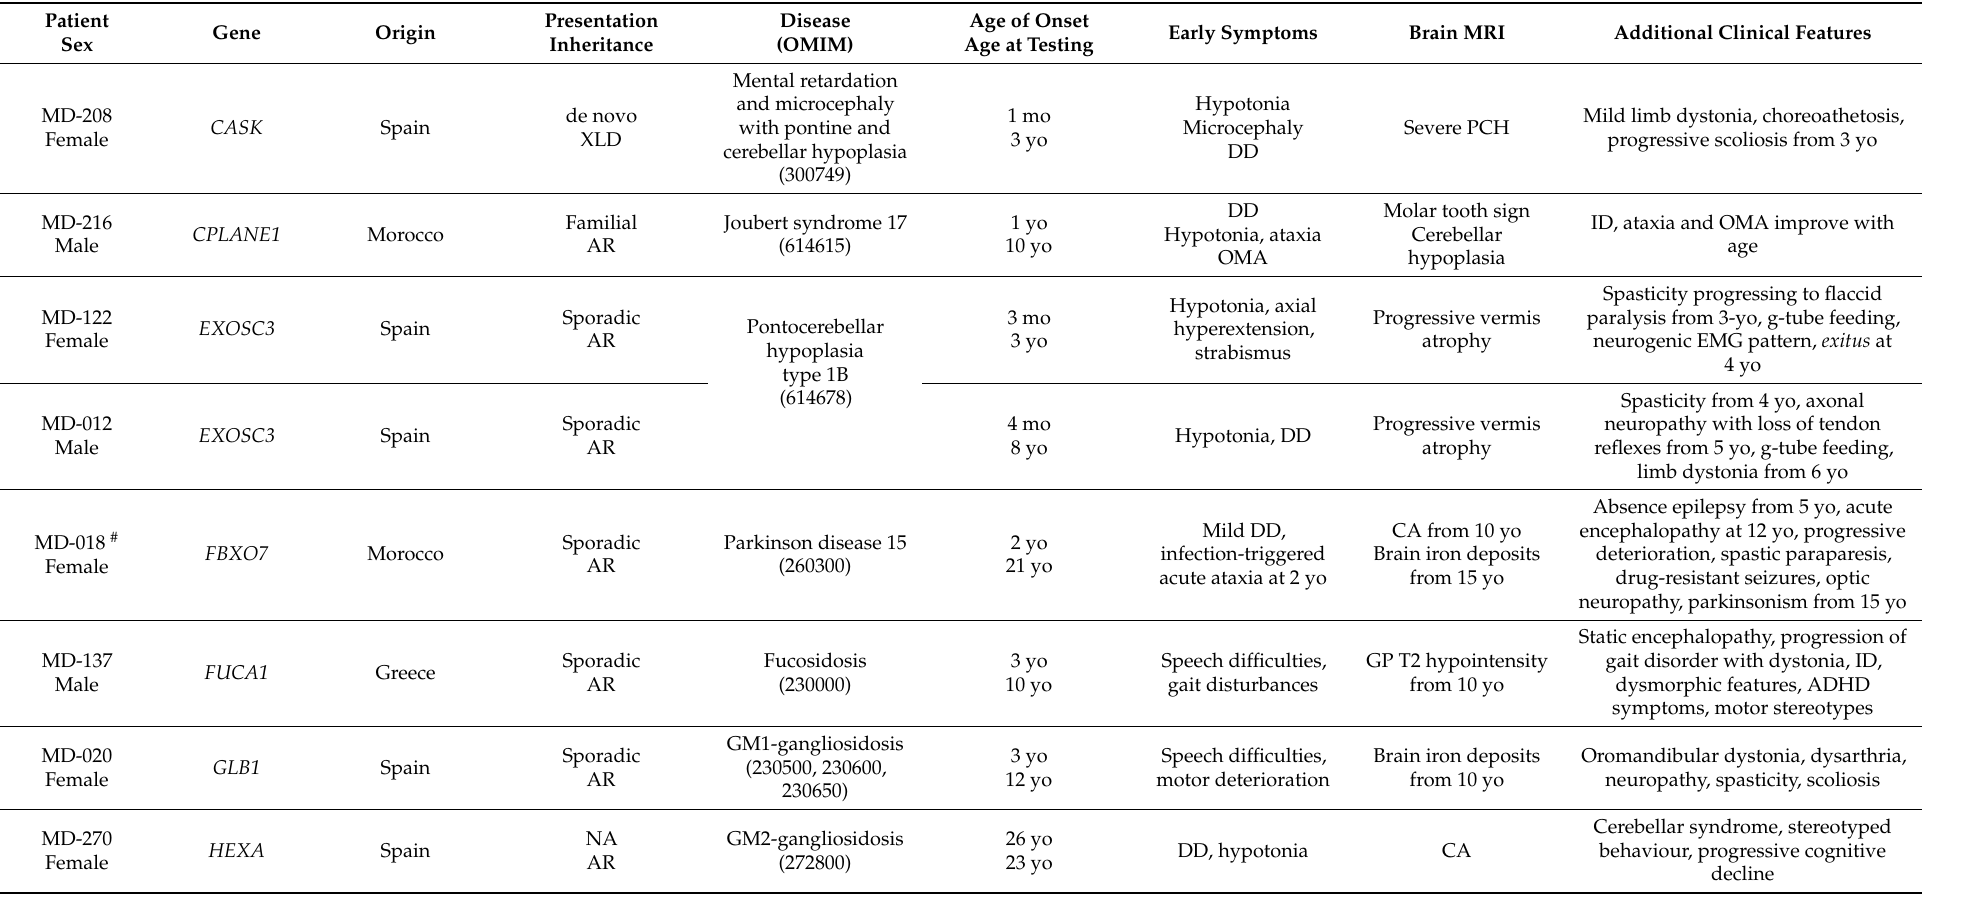
Table 2. Clinical features of the 29 solved